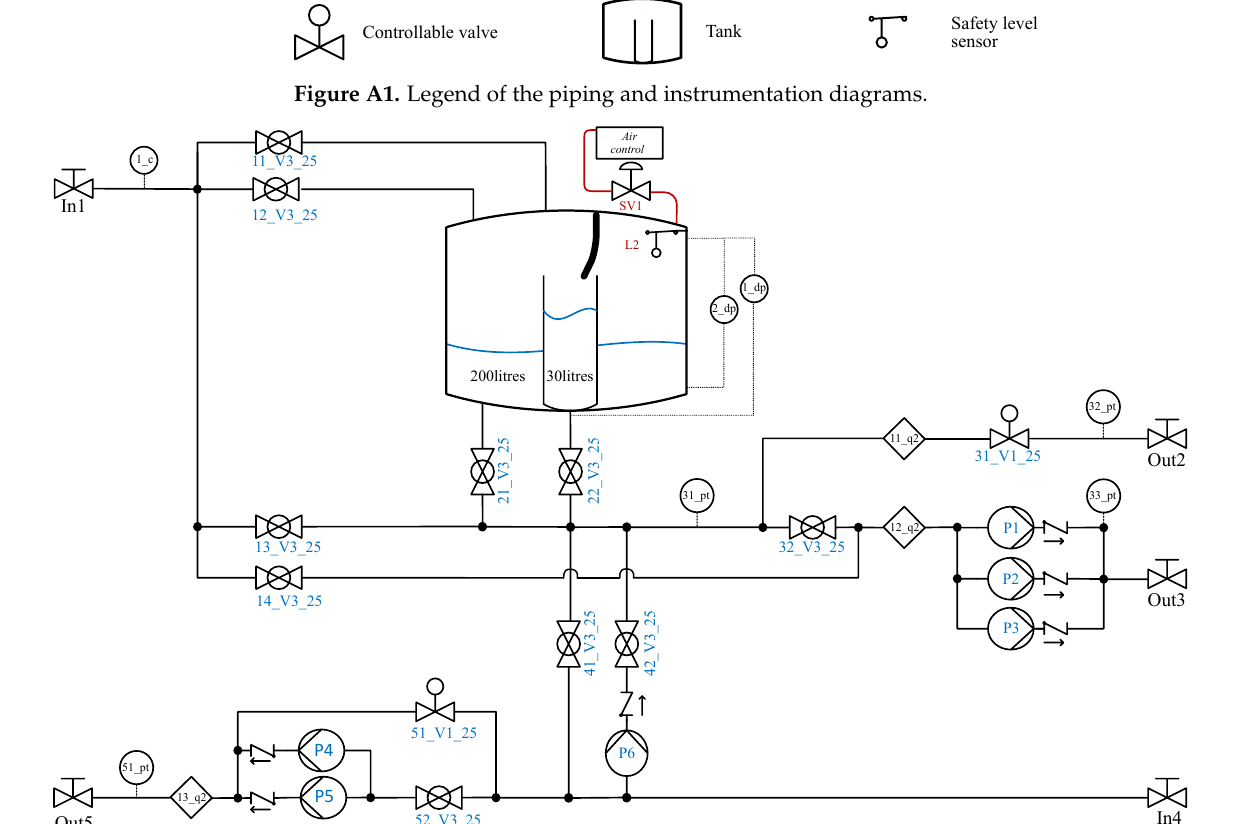
Figure A2. Piping and instrumentation diagram of the pumping station unit. The legend is shown in Figure A1 and the details for each component are listed in Table A1. Shut-off valves are locally controlled to block or bypass different hydraulic circuits, thus enabling different features.